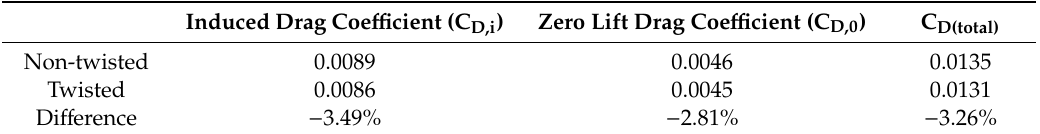
Table 4. Drag coe ffi cient reduction following wing